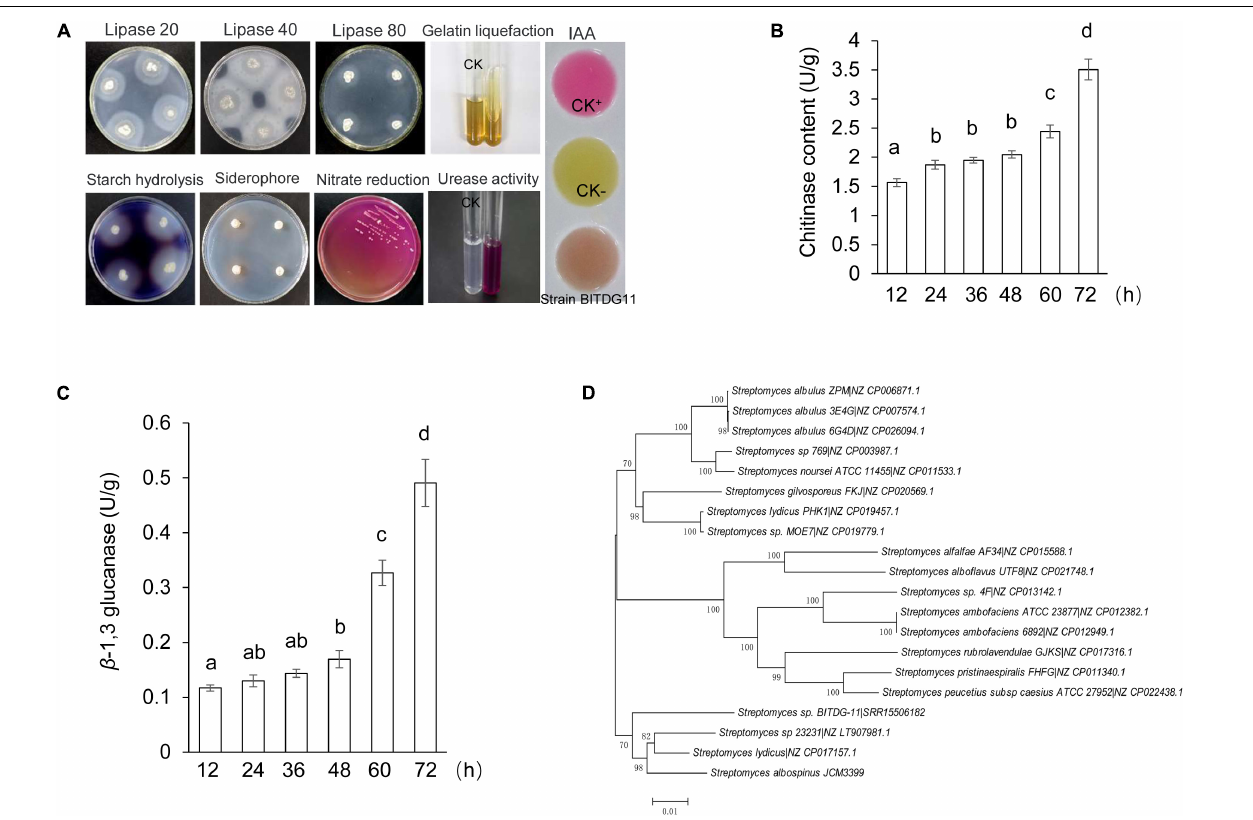
FIGURE 2 | Physicochemical property and identification of Streptomyces BITDG-11. (A) Physicochemical properties of Streptomyces BITDG-11. (B) Measurement of chitinase production during the culture process of Streptomyces BITDG-11. (C) Measurement of β -1,3-glucanase production. Data are the mean values from three biological repeats. Different lowercase letters indicate a significant difference in comparison with the initial time point of the strain growth (LSD’s multiple range test, p < 0.05). (D) Construction of phylogenetic tree based on MLSA using the neighbor-joining method. The confidence level at all nodes was investigated using bootstrap analysis on 1,000